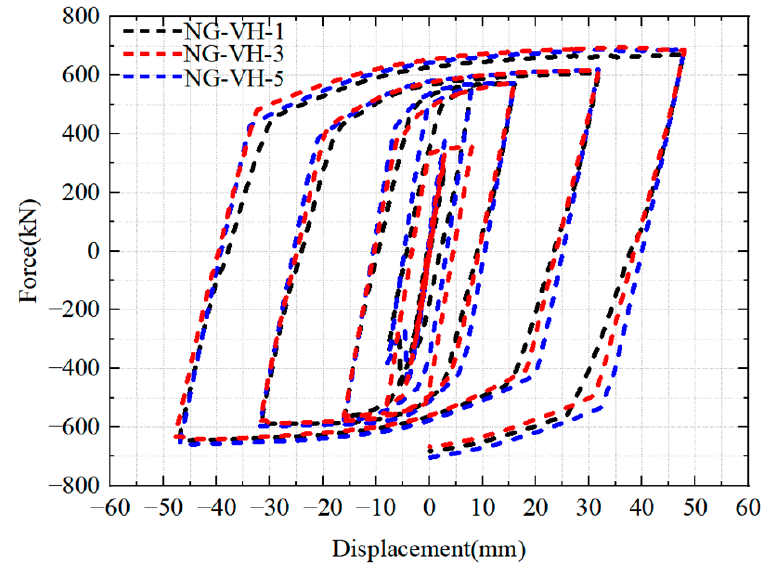
Figure 14. Comparison of hysteretic responses of the BRB-RCBs with two-sided slotted gusset con- nection with bidirectional sliding bolts.